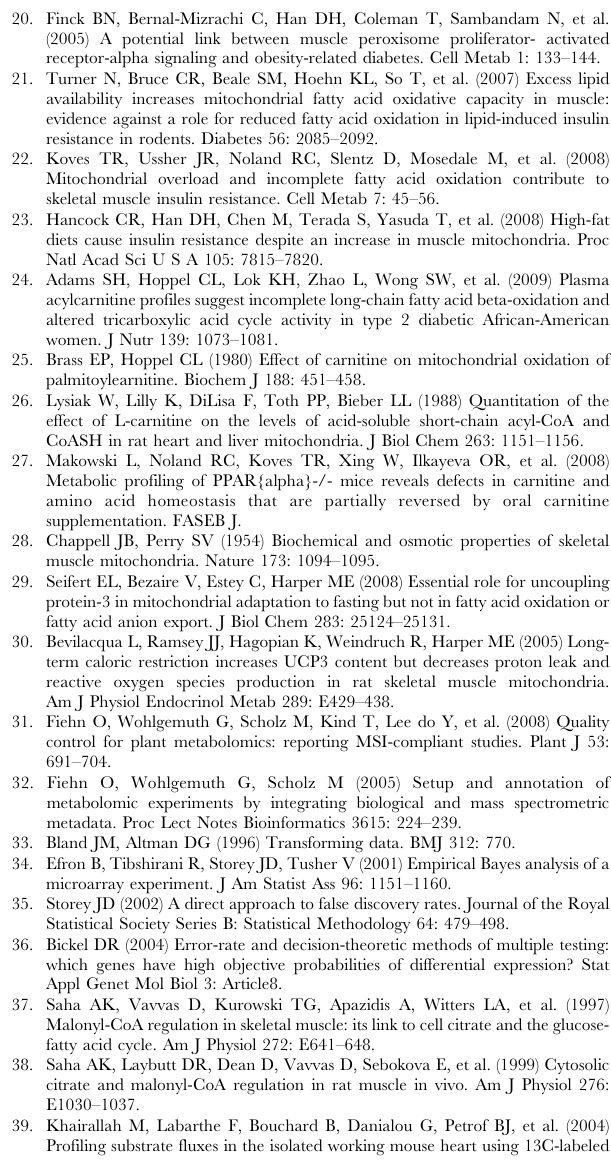
Table S1 Bioenergetic status of murine skeletal muscle mito- chondria oxidizing palmitate: Supplementary Table and accom- panying Results and Discussion.